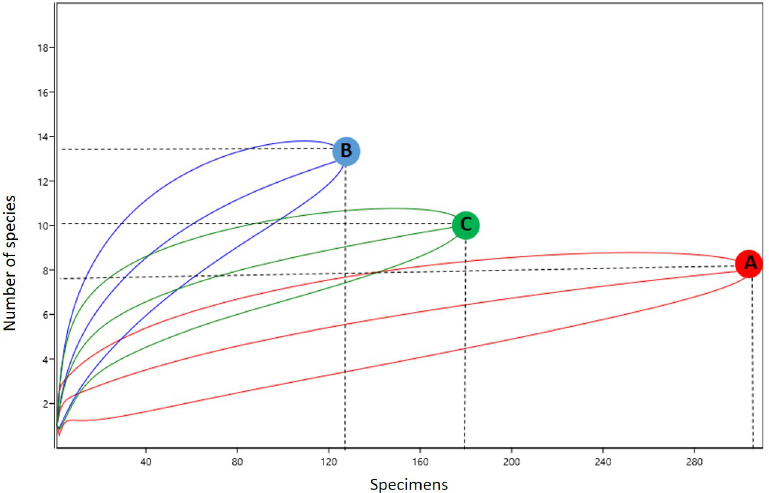
Fig 5. Rarefaction curves representing species richness of mosquitoes collected by horizontal stratification. (A) Peridomicile; (B) Forest edge; (C) Forest environment of the Rio Pardo settlement, Presidente Figueiredo Municipality, Amazonas State,